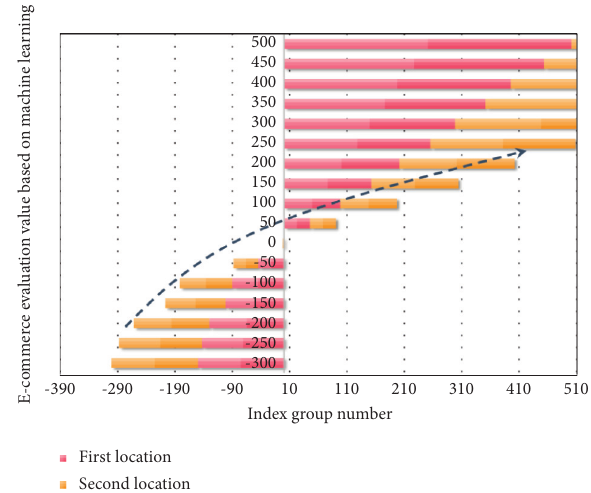
Figure 4: Numerical analysis of e-commerce evaluation based on machine